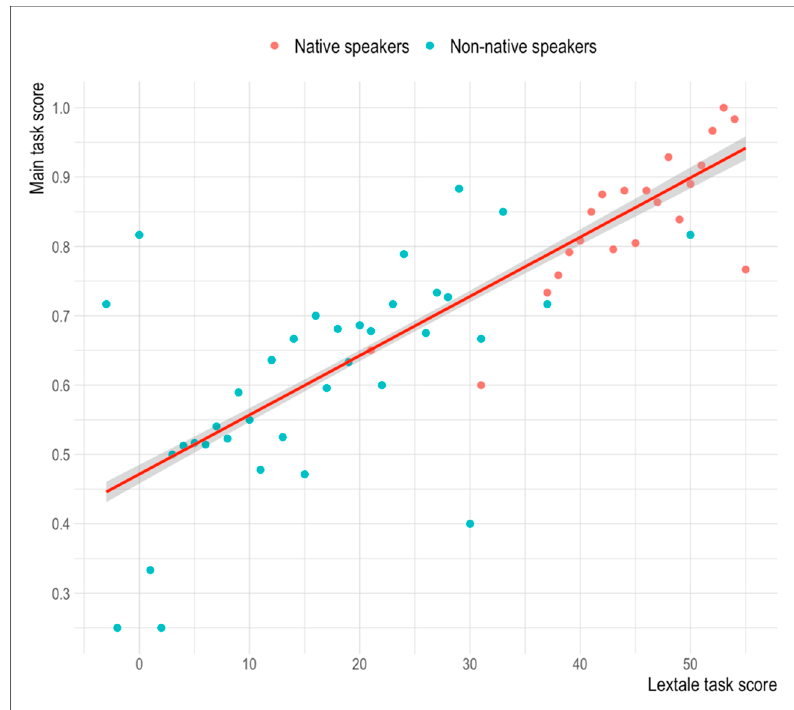
Figure 12. Relation between the scores in the main task and in the Lextale task by the non-native and native participants .